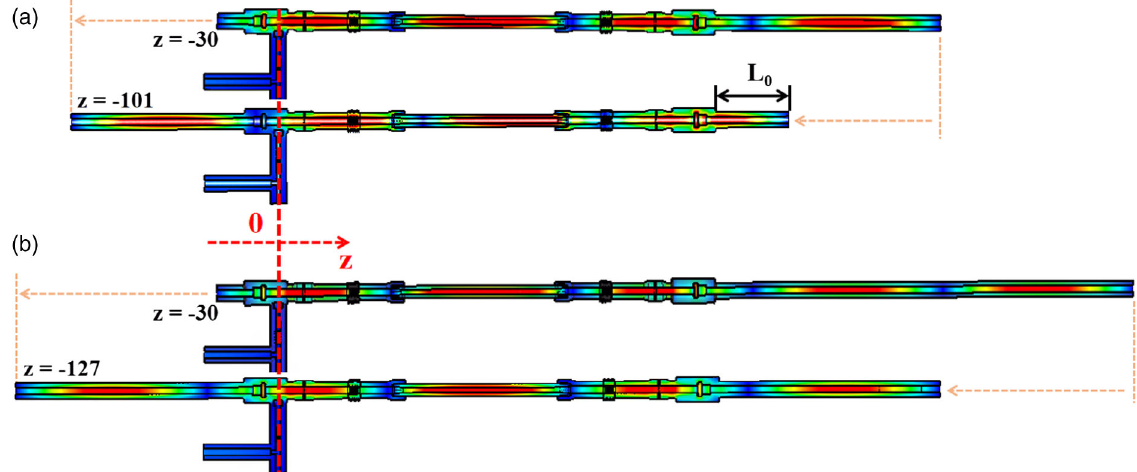
FIG. 4. The electric field distributions in the resonant cavities with four and five antinodes at 162.5 MHz. The movable shorts are at the limited positions, and the axis of the tunable secondary coupler lies at z ¼ 0 cm. (a) shows the resonant field in the cavities having four field antinodes, with the left short located at z ¼ − 30 and − 101 cm; (b) shows the resonant field in the cavities having five field antinodes, with the left short located at z ¼ − 30 and − 127 cm.